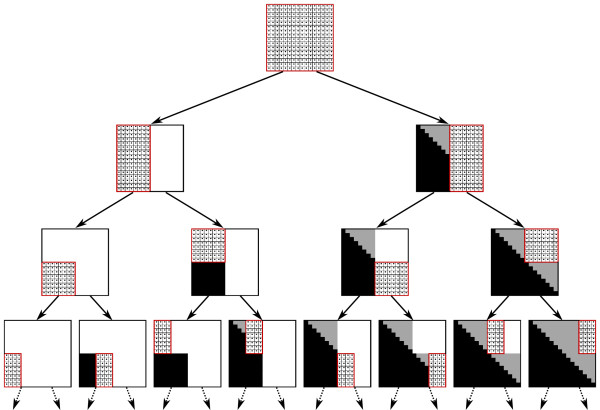
The recursion tree. Each node in the tree shows the state of the matrix B when the respective call to Compute-Inside-Sub-Matrix starts. The dotted cells are those that are computed during the call. Black and gray cells are cells whose values were already computed (black cells correspond to empty substrings). The algorithm starts by calling the recursive procedure over the complete matrix. Each visited sub-matrix is decomposed into two halves, which are computed recursively. The recursion visits the sub-matrices according to a pre-order scan on the tree depicted in the figure. Once the first among a pair of sibling recursive calls was concluded, the algorithm uses the new computed portion of data as an input to a fast matrix multiplication subroutine, which facilitate the computation of the second sibling.